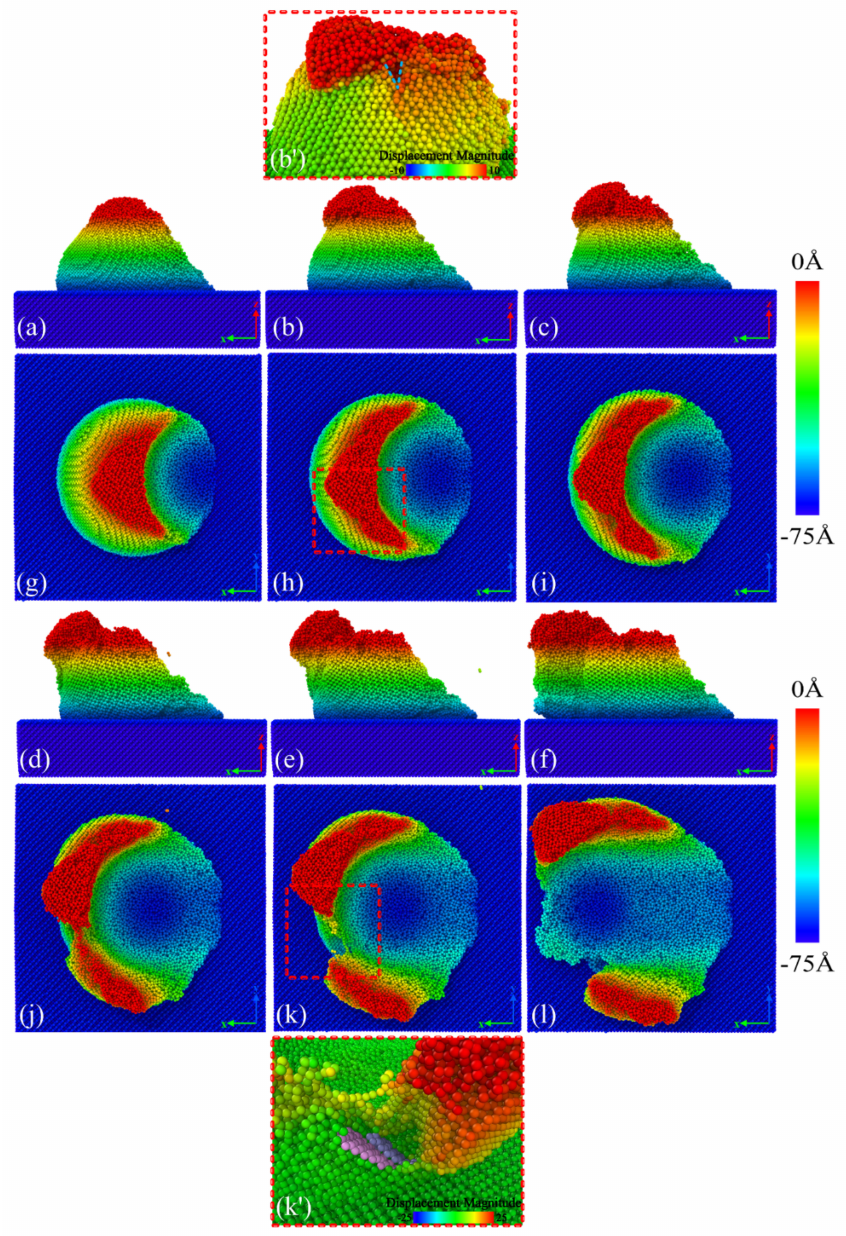
Figure 2. Deformation behaviors of single asperity GaAs(001) during plowing at ( a , g ) 7 nm, ( a – f ) is the main view and ( g – l ) is the top view. Each atom was colored according to its height of normal direction. ( b’ ) and ( k’ ) show local views of the dashed part, whose atoms were colored according to the displacement magnitude. In ( b’ ), the blue V line indicates the place where the crack started. In ( k’ ), the pink and blue atoms highlight the smooth surface where the crack